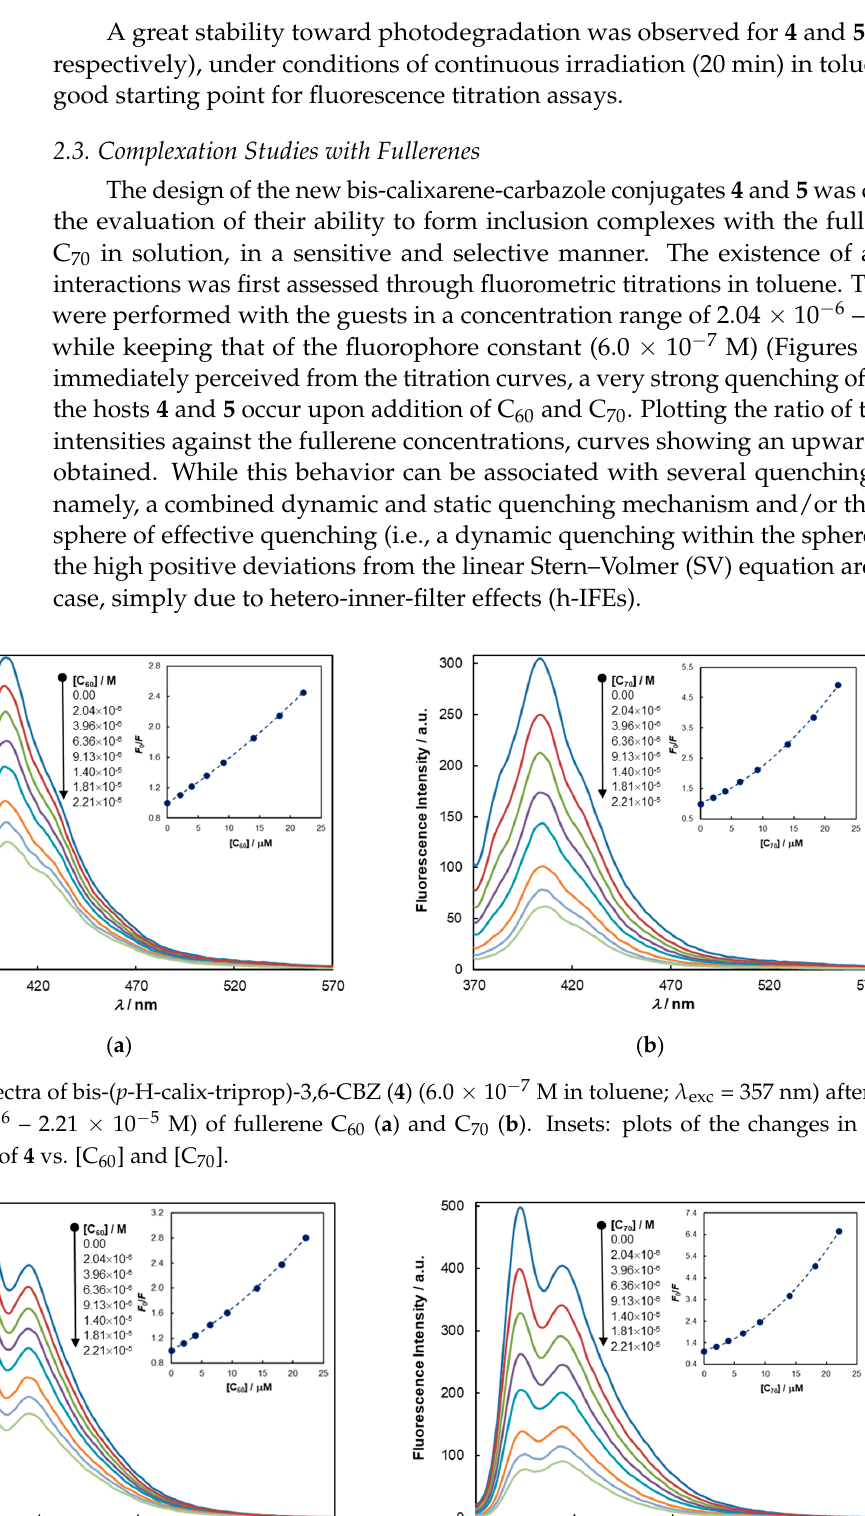
Figure 2. Time ‐ resolved intensity decay of bis ‐ calixarene ‐ 3,6 ‐ CBZ ( 4 ) in toluene obtained by the single ‐ photon timing method under excitation at 340 nm.